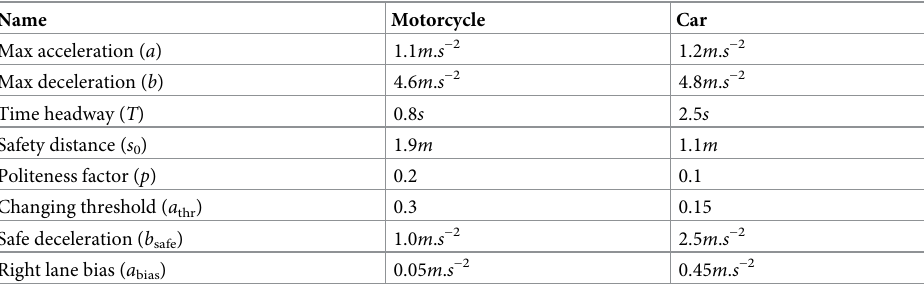
Table 11. Driver parameter values for Hanoi.